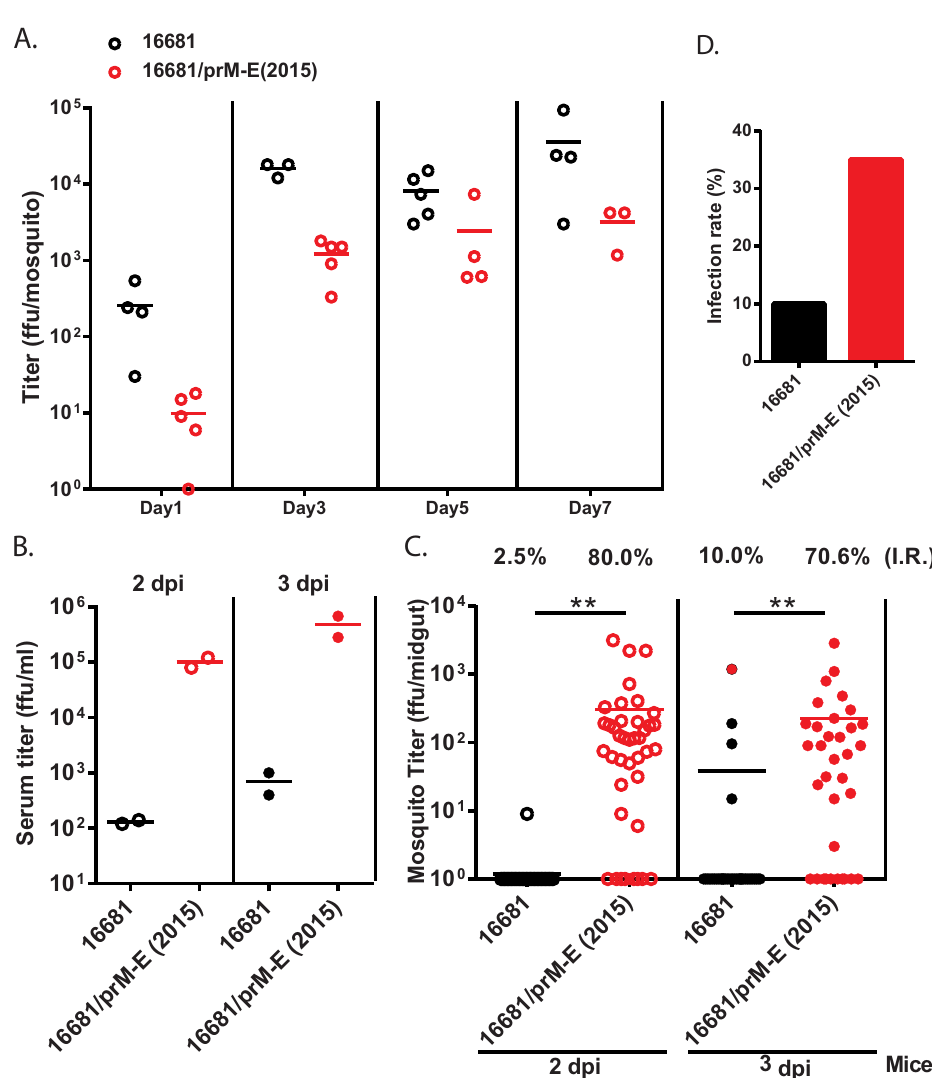
Fig 7. The TW2015 PrM-E facilitated virus transmission from mammalian host to mosquito vector. (A) Viral titer in whole Aedes aegypti mosquitoes infected with DENV-2 viruses (thoracic injection, 160 pfu/mosquito; 7 dpi; n = 5). (B-C) AGB6 mice infected with the 16681 virus or the 16681/prM-E(2015) mutant (iv, 1 × 10 5 pfu/mouse; n = 2) and used to feed na ï ve mosquitoes on 2 and 3 dpi. (B) Serum titer of AGB6 mice (C) Viral titer in mosquito midgut (n = 30–40) at 7 days after feeding on blood from of the infected AGB6 mice. (D) The infection rate at 7 dpi of na ï ve mosquitos artificially fed with mouse blood containing 5 × 10 5 pfu/ml of cultured 16681 virus or the 16681/prM-E (2015)